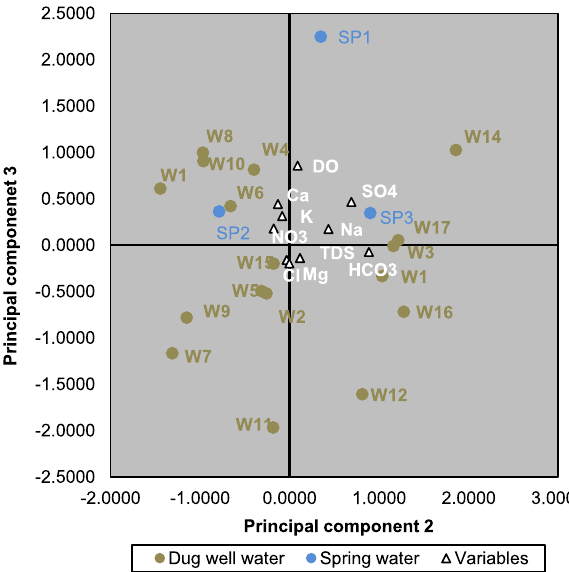
Fig. 11 Third versus second principal component